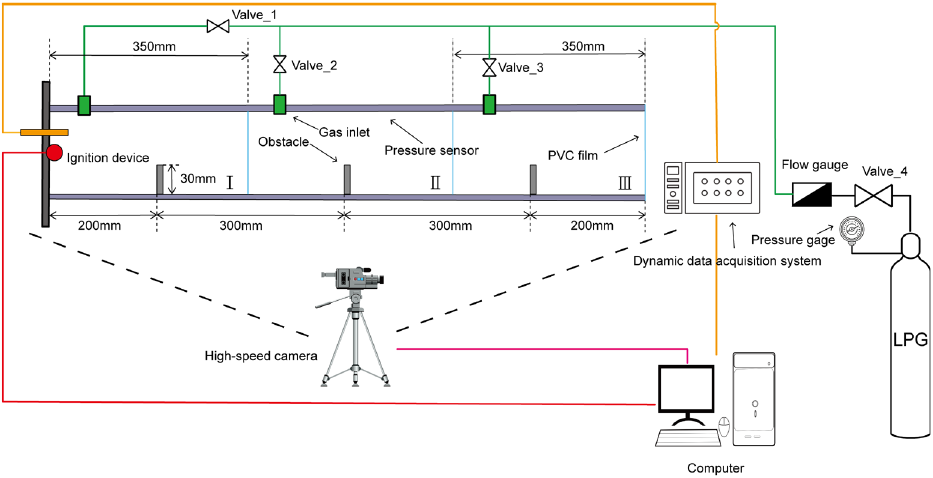
Figure 1. Experimental schematic.